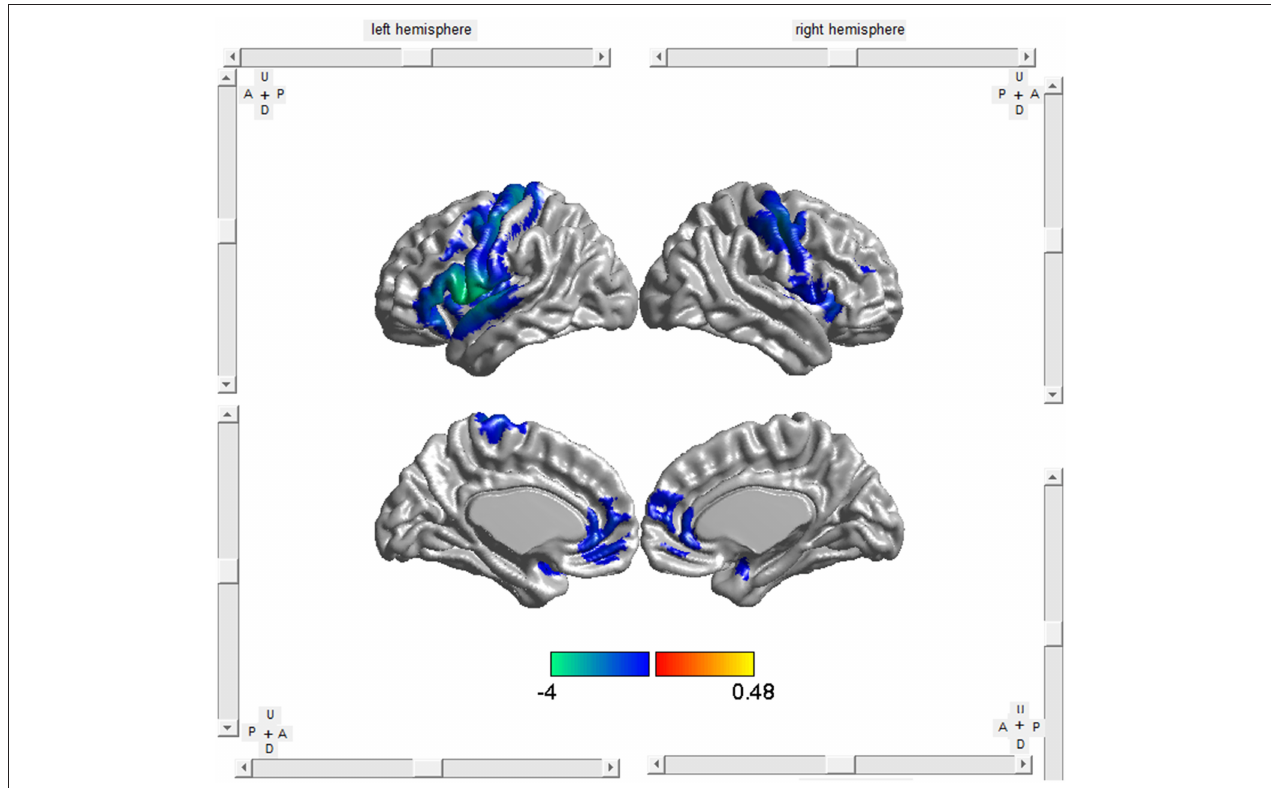
FIGURE 2 | Brat v1.0 (http://www.brainnetome.org/brat) software was used to visualize the anatomical distribution of GM atrophy in ALS compared with HCs. Patients with ALS had significant GM reductions in bilateral Rolandic operculum, the right precentral gyrus, the left lenticular nucleus and the right anterior cingulate/paracingulate gyri. The color bar indicates the range of the SDM-Z values.